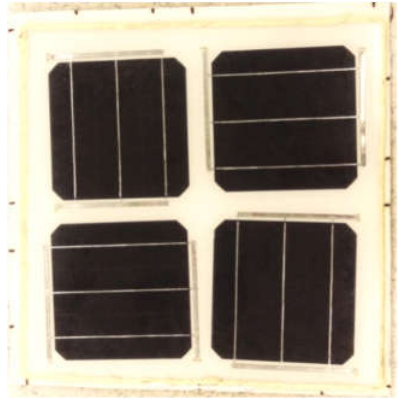
Figure 3. The photo of the (PID) test module with four cells packaged separately.